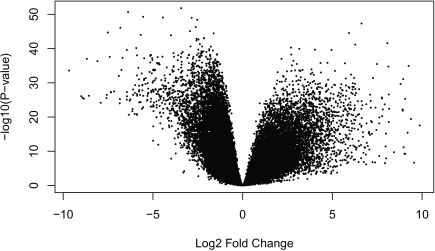
Volcano plot of the gene level data.Testing for prenatal and postnatal DE adjusting for sex and RIN.